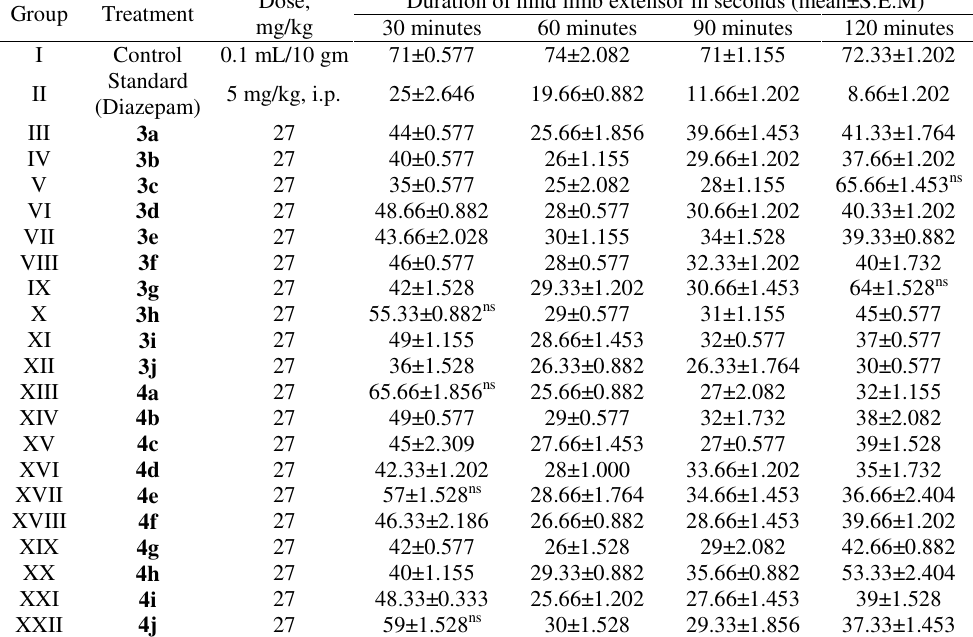
Table 1. Duration of hind limb extensor of the synthesized compounds